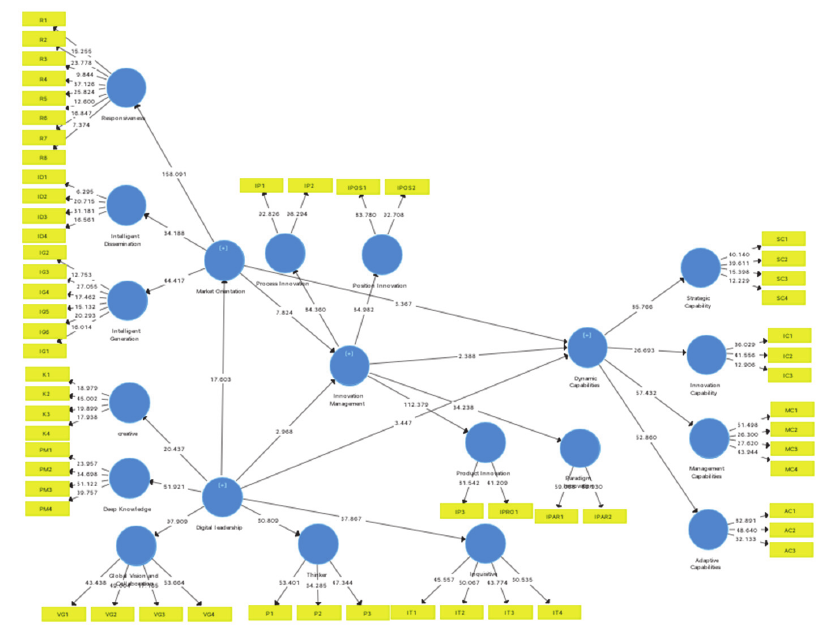
Fig 3. The Complete Research